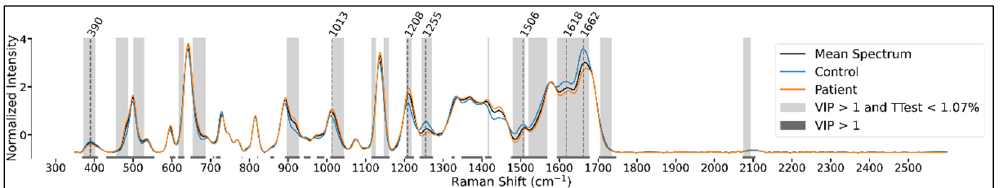
Figure 4. Mean spectra with emphasized T-test significance and VIP > 1 for plasma samples.